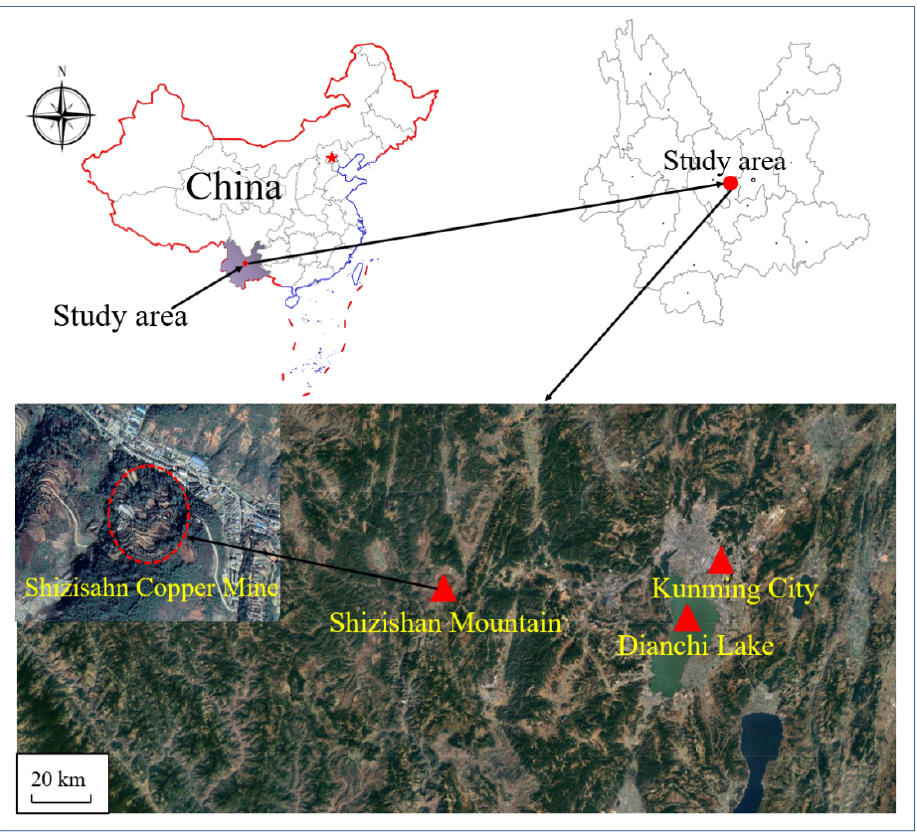
Figure 1. Position and regional structure outline of Shizishan Copper Mine.